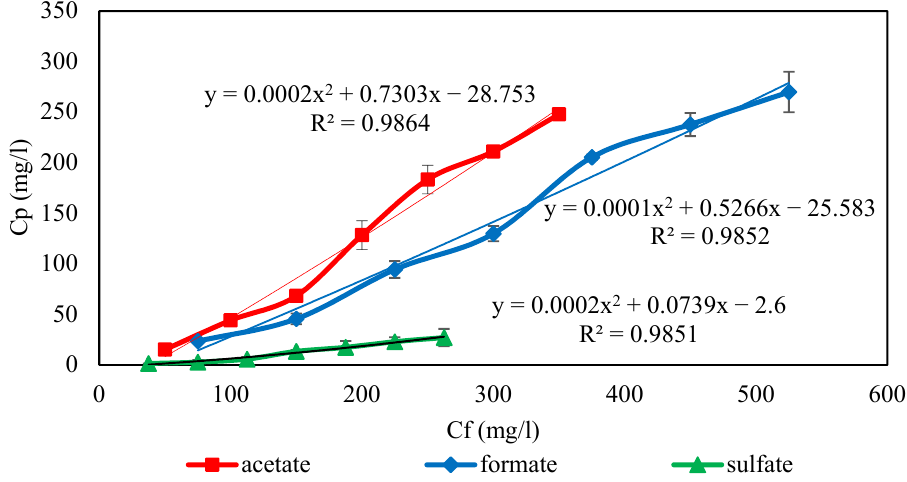
Figure 3. Effect of feed concentration on permeate concentration for ternary salts of 45 wt. % MDEA solution by NF membrane at 70 bar (T = 35 ◦ C, pH = 10).